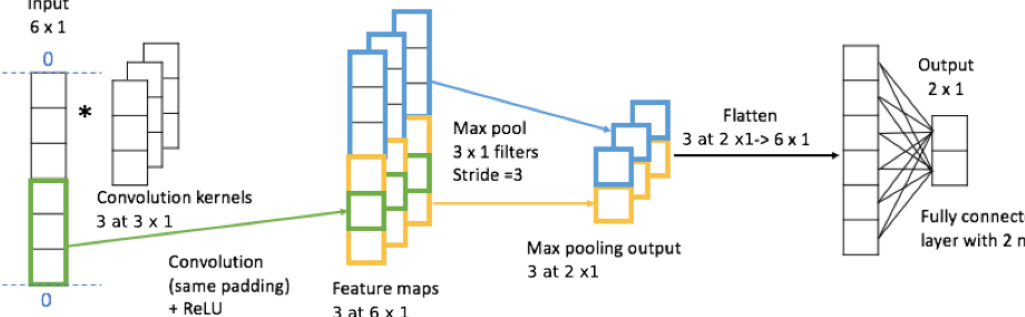
Figure 1. Schematics of a simple CNN.